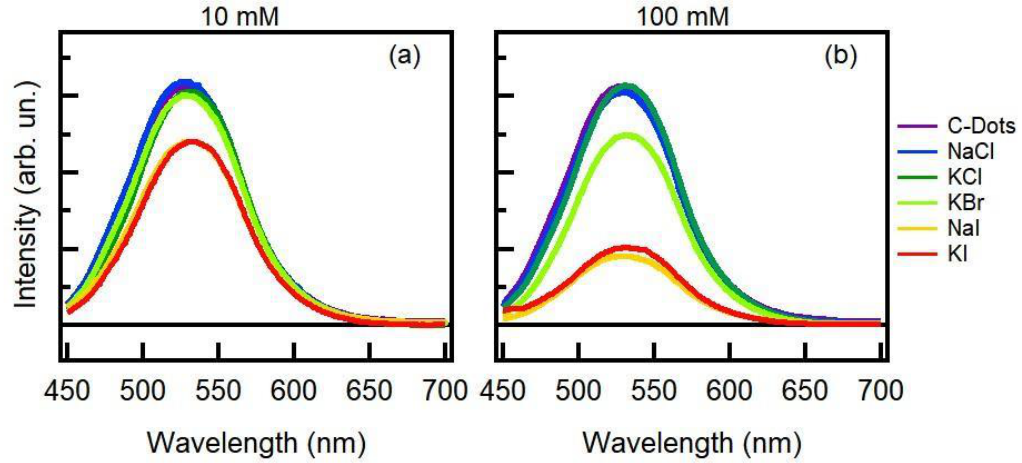
Figure 3. Emission spectra of bare C-dots (purple curve, both panels), of C-dots with 10 mM of salt ( a ) and with 100 mM of salt ( b ). Salt list: NaCl (blue curves), KCl (dark green curves), KBr (light green curves), NaI (Yellow curve) and KI (red curves).